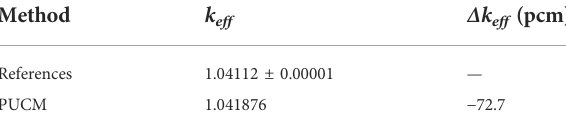
TABLE4 k eff for